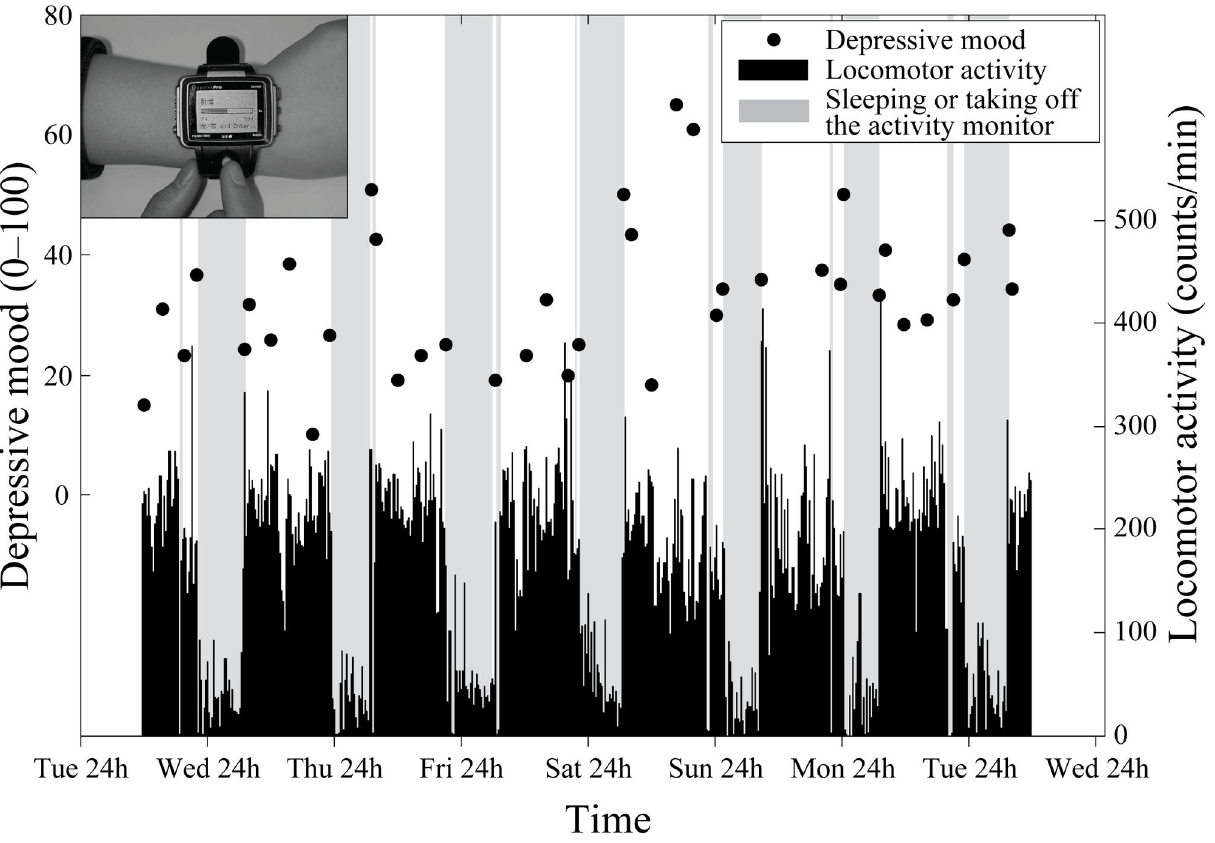
Figure 3. Fluctuation of depressive mood and locomotor activity in an office worker. Filled circles indicate depressive mood scores (y-axis on the left side) recorded by ecological momentary assessment (EMA) over seven consecutive days. The inset in the upper left represents the watch-type activity monitor equipped with EMA software. The locomotor activity measured simultaneously (zero-crossing counts within every 1 min time interval) is also shown (y-axis on the right side). The periods shaded in gray are times during which the subject was sleeping or had taken off the